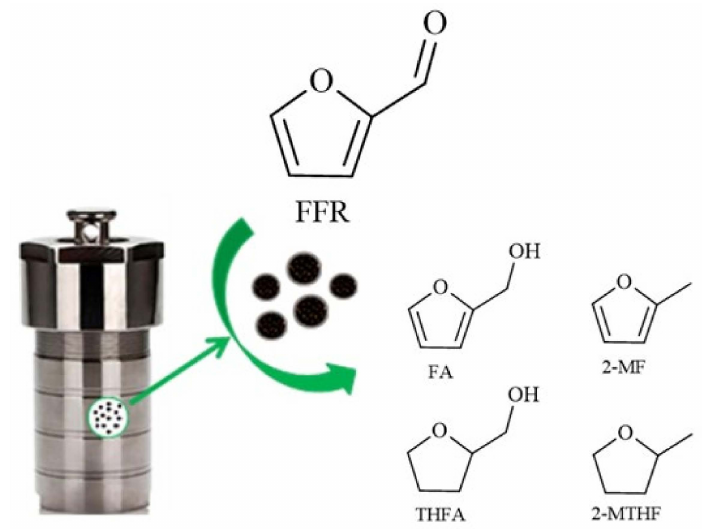
Figure 1. Scheme of support modification by diazonium salts and immobilization of Pd and Au nanoparticles.